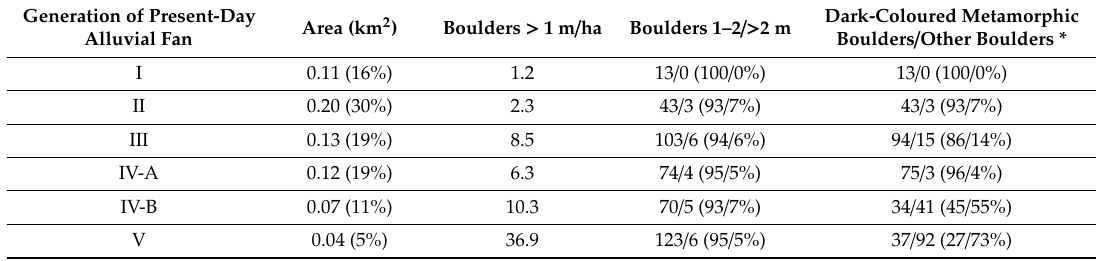
Table 3. Area, and number and properties of boulders on the surfaces of the di ff erent generations of the present-day alluvial